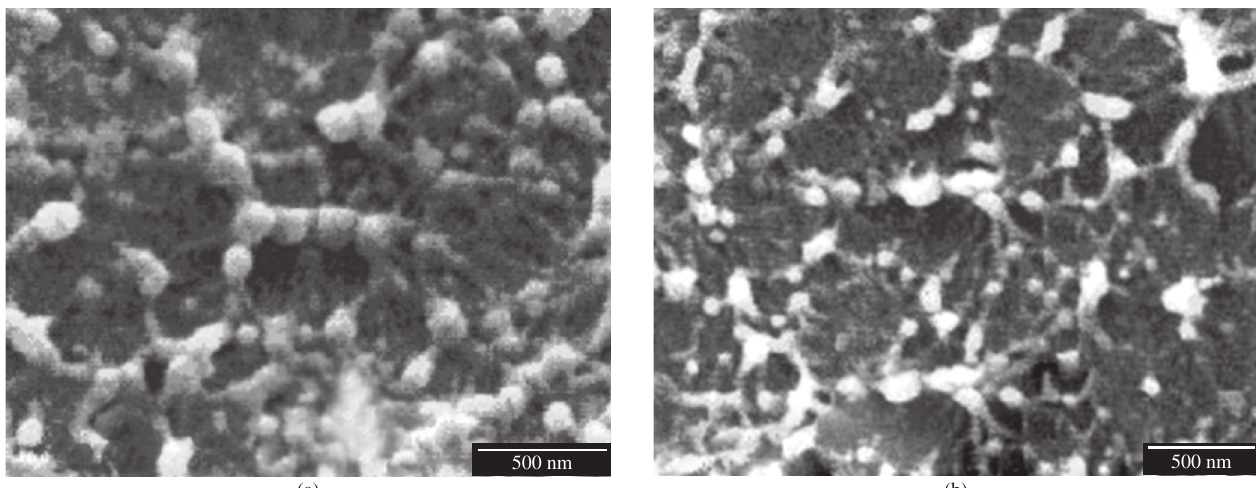
Figure 3. SEM micrographs of samples: a) LDPE CBC and b) LDPE CBTS with CB aggregate sizes of 210 nm and 100 nm